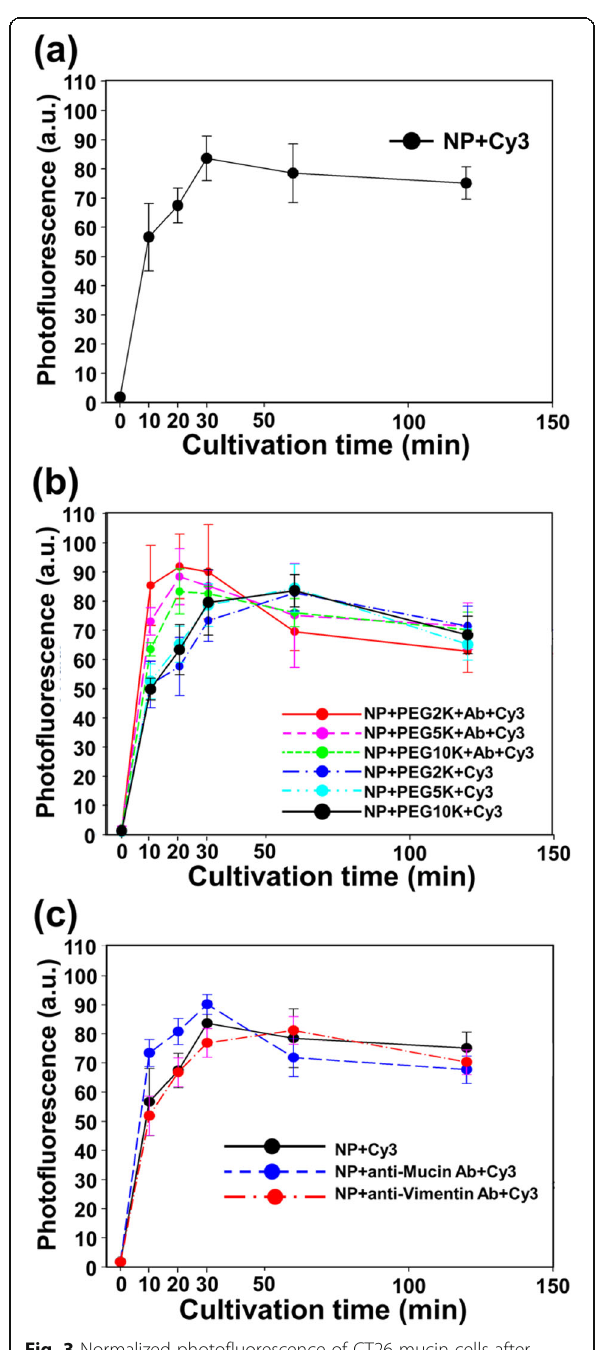
Fig. 3 Normalized photofluorescence of CT26 mucin cells after incubation with 50 μ g/mL a Fe 3 O 4 -Au NPs, b PEGylated NPs and PEG-nanobody-tagged NPs, and c Fe 3 O 4 -Au NPs, nanobody-tagged NPs, and vimentin-tagged NPs at 37 °C in 5% CO 2 for different periods (10, 20, 30, 60, 120, and 360